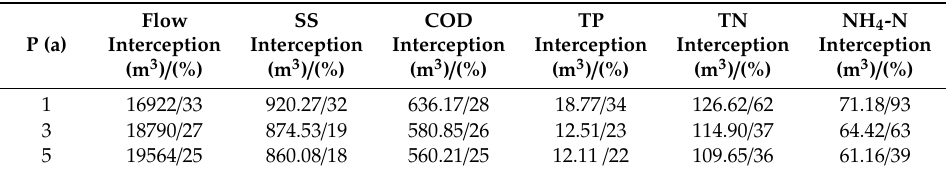
Table 6. Interception statistics of traditional interception weir.